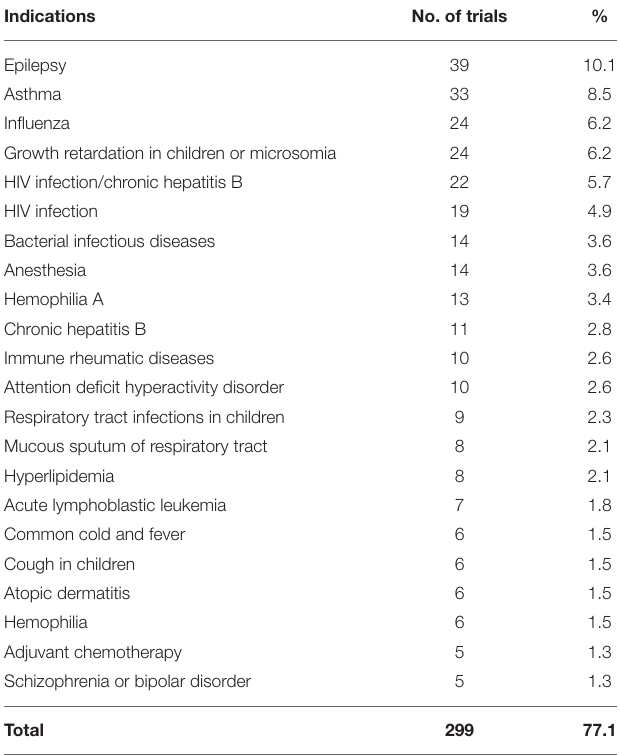
TABLE 6 | Distribution of clinical trials by indications.